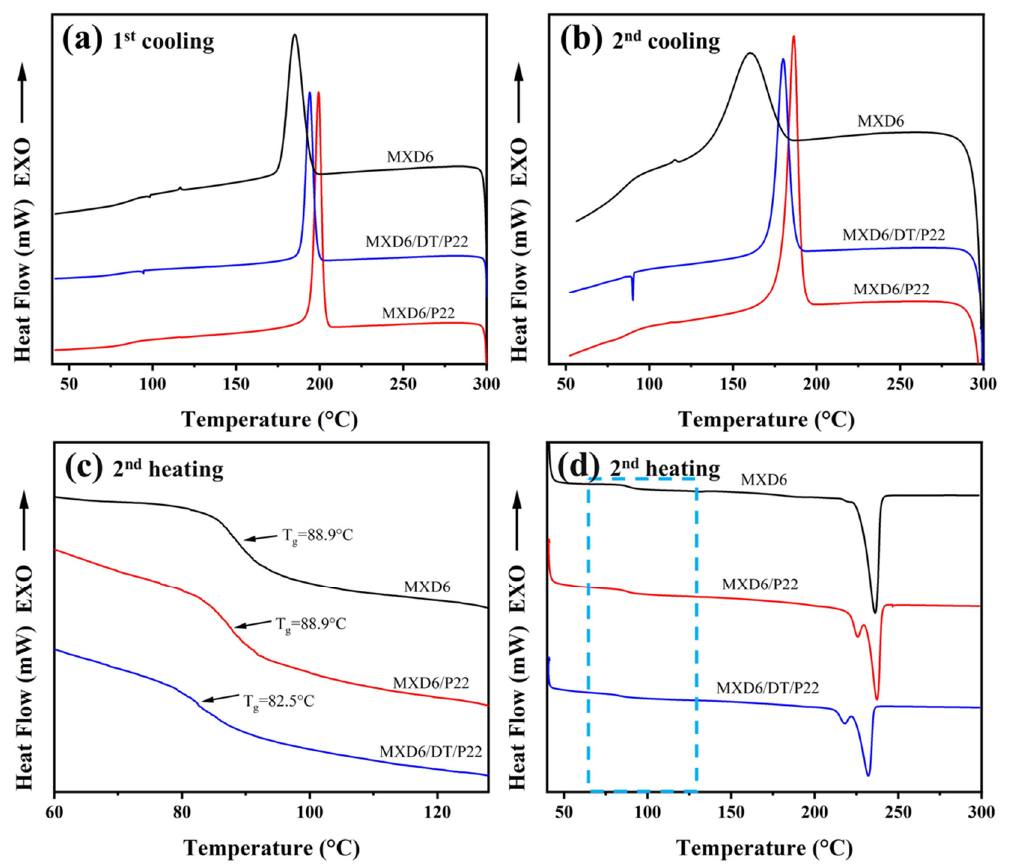
Figure 1. DSC curves of neat and modified MXD6: ( a ) first cooling (10 ◦ C/min) ramp, ( b ) second cooling (40 ◦ C/min) ramp and ( c , d ) second heating (10 ◦ C/min) Table 2. The non-isothermal crystallization results of neat and modified MXD6.